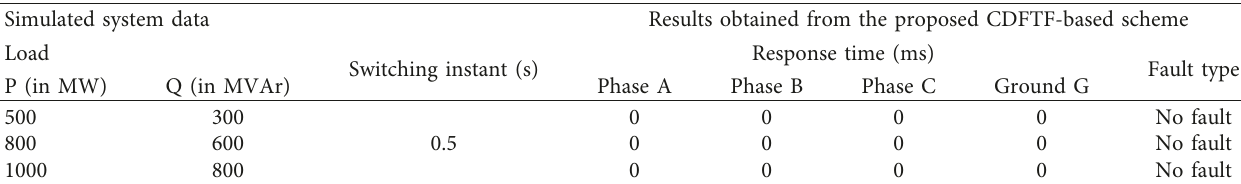
0 ° , FR 20 , and f 61Hz: (a) 3-phase (cid:31) (cid:31) (cid:31) Ω 0 ° and FL 165km). (cid:31) (cid:31)